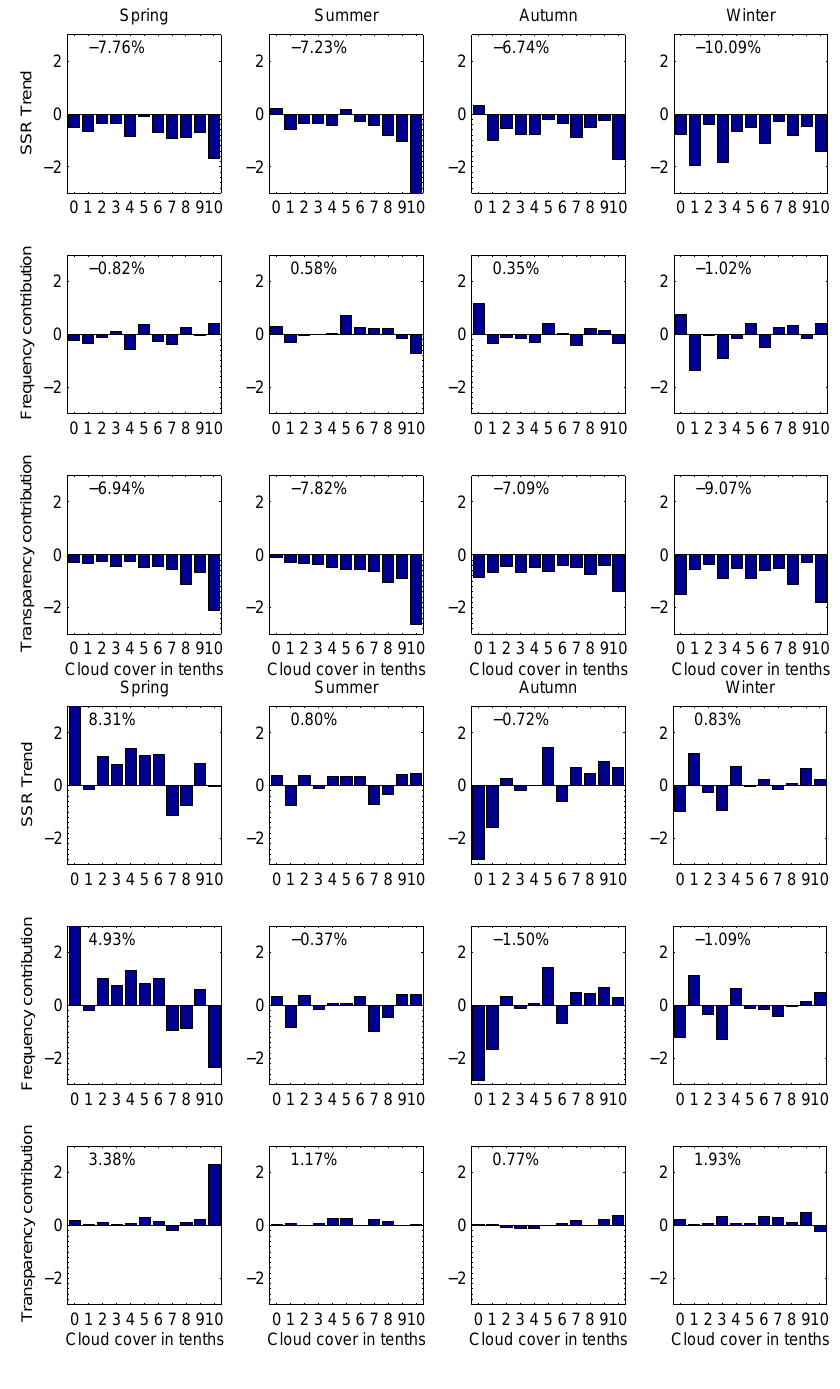
Fig. 8. The same as in Fig. 7, but in Southeast